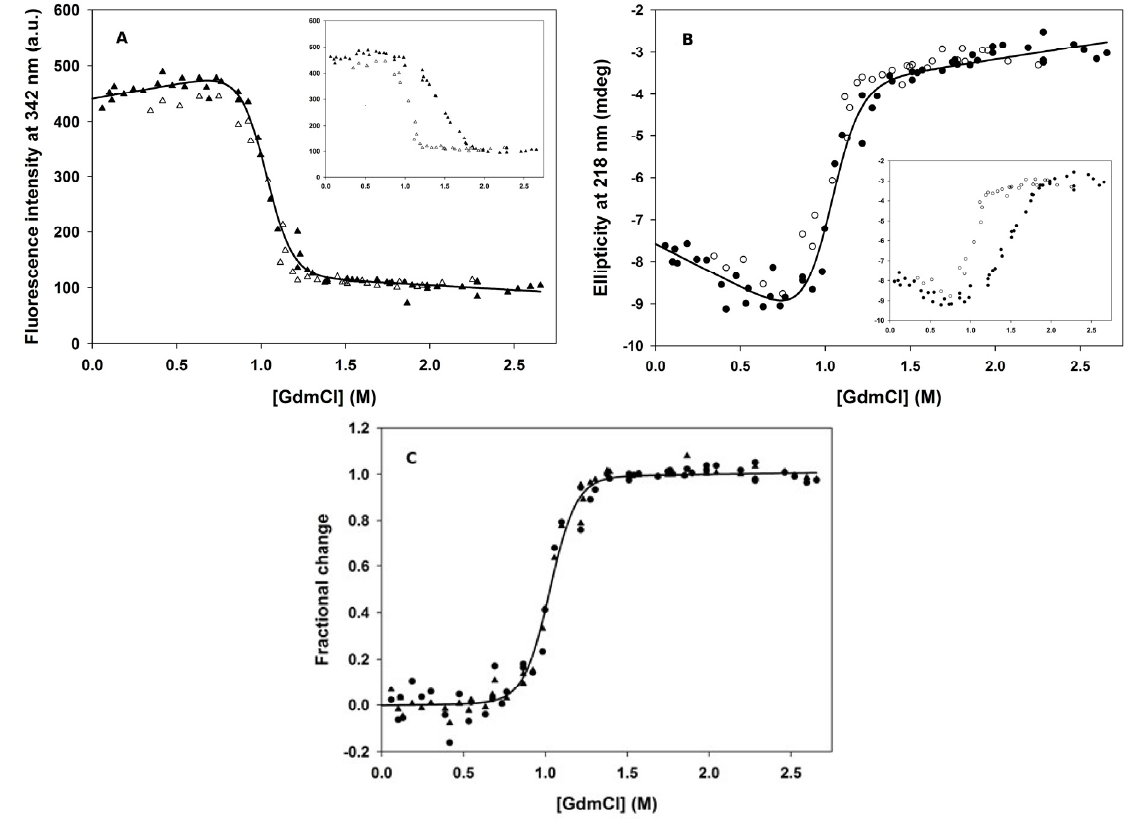
Figure 3. GdmCl-induced equilibrium unfolding transitions of PemA at pH 7 and 25 ◦ C, monitored by ( A ) the change in fluorescence intensity at 342 nm and ( B ) the change in ellipticity at 218 nm. Closed symbols represent the addition of a denaturant to a solution of native protein, whereas open symbols are for the dilution of unfolded protein (in 3 M GdmCl) to the indicated concentrations of GdmCl. The samples were incubated at the indicated GdmCl concentra- tions for 9 days before the measurements. Data were analyzed on the basis of a two-state model [91], and the lines were drawn using ( A ) ∆ G ◦ (H 2 O) NU = 32 ± 3 kJ · mol − 1 , m NU = − 31 ± 3 kJ · mol − 1 · M − 1 and C m = 1.0 ± 0.1 M, and ( B ) as a function of GdmCl concentration. Triangles and circles represent fluorescence and far-UV CD data, respectively. The line was drawn using the average value for the parameters obtained in fluorescence and CD experiments (see text). Insets in ( A , B ) represent data obtained after circa 20 h of incubation (see